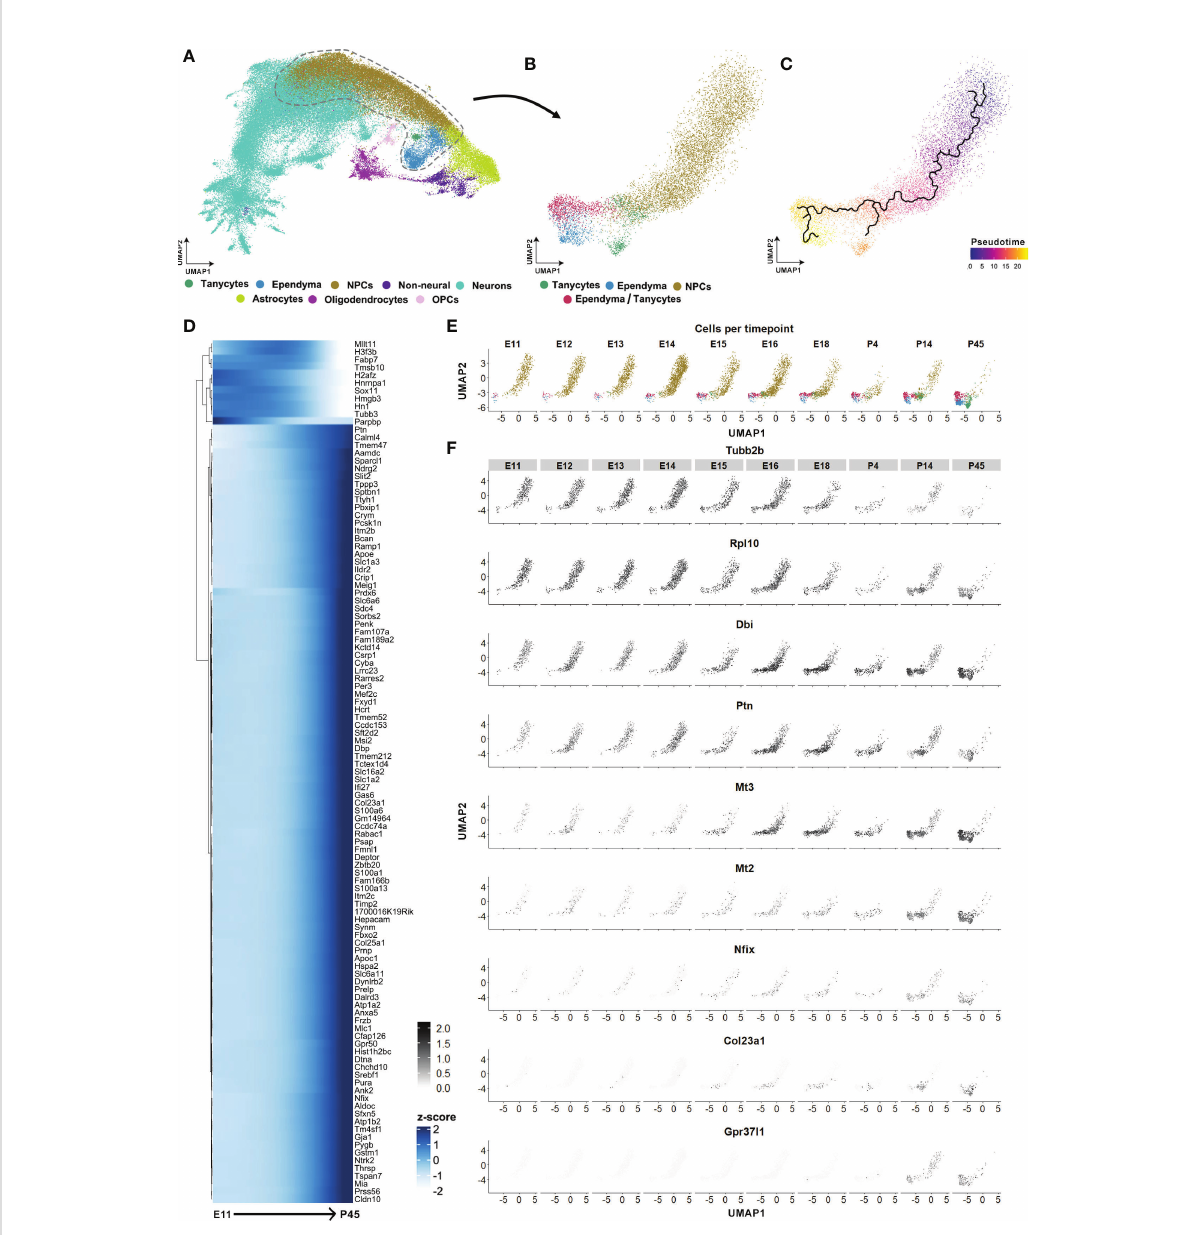
FIGURE 8 Tanycyte and ependyma developmental trajectories. (A) UMAP showing the integrated developmental scRNAseq datasets from hypothalamic and diencephalic explants between E11 and P45 (excluding E10 and P8 datasets) from Kim et al. (26). (B) UMAP showing the subclustering of progenitor cells (NPCs), tanycytes, ependyma, and tanycyte/ependymal cell populations. (C) UMAP plot displaying the pseudotime ependymal and tanycyte trajectories originating from NPCs. (D) Heatmap displaying the fi rst 100 genes expressed in the pseudotime NPC to tanycyte trajectory. (E) UMAP displaying the development of tanycytes and ependymal cells split by age from E11 to P45. (F) UMAP showing features expressed across the developmental trajectory from NPCs to the tanycyte population. See Figure